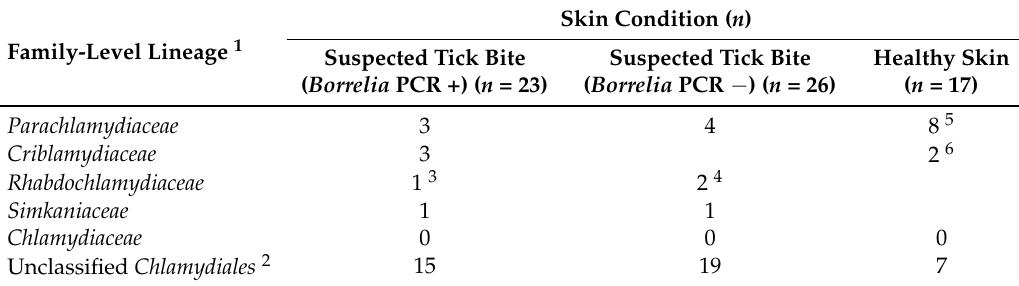
Table 3. Chlamydiales family-level lineages based on sequencing of the 16S rRNA gene fragment of pan- Chlamydiales PCR-positive skin biopsies ( n = 66). Genus- and species-level information is shown in footnotes (if the level of classification could be